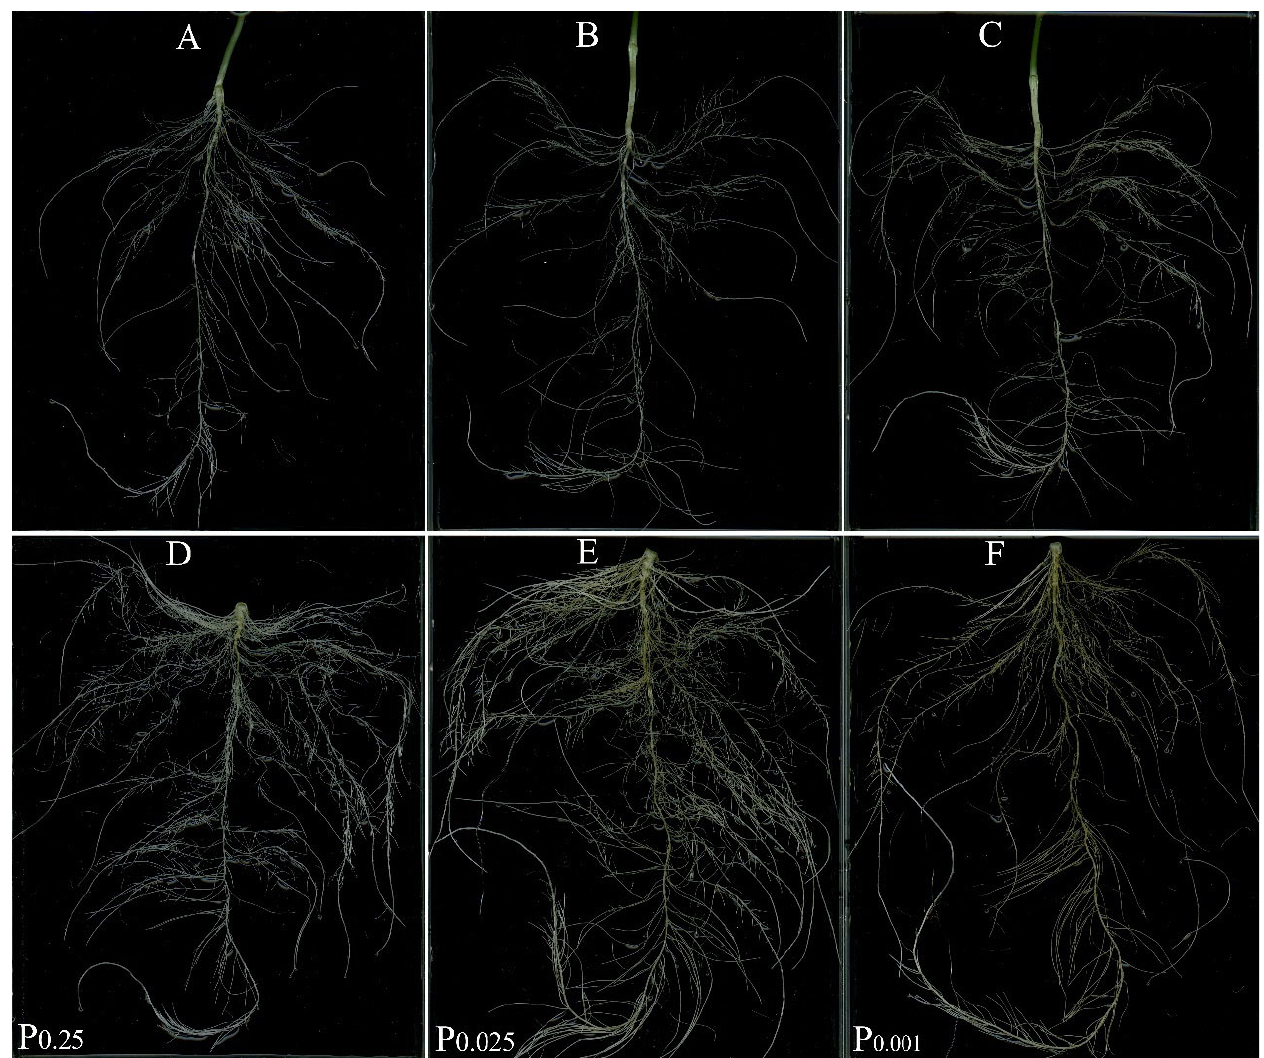
Figure 2. The representative phenotype of melon seedling roots under low ‐ Pi stress at the 7th day after treatment ( A – C ) and the 14th day after treatment ( D – F ). The roots were scanned to produce these images (EPSON Perfection V700 Photo scanner, Epson, Nagano, Japan) ( n = 3, 3 subsamples of each replicate). Table 3. Total root length (TRL), root surface area (SA), root volume (V), root average diameter (D), primary root length (PRL), and lateral root zone length (LRZL) of melon seedlings. The values are presented as the mean ± SD ( n = 3, 3 subsamples of each replicate). The lowercase letters indi ‐ cate the significant difference in the parameter, at the same treatment time, among the treatments using one ‐ way ANOVA with Tukey’s test ( p < 0.05).